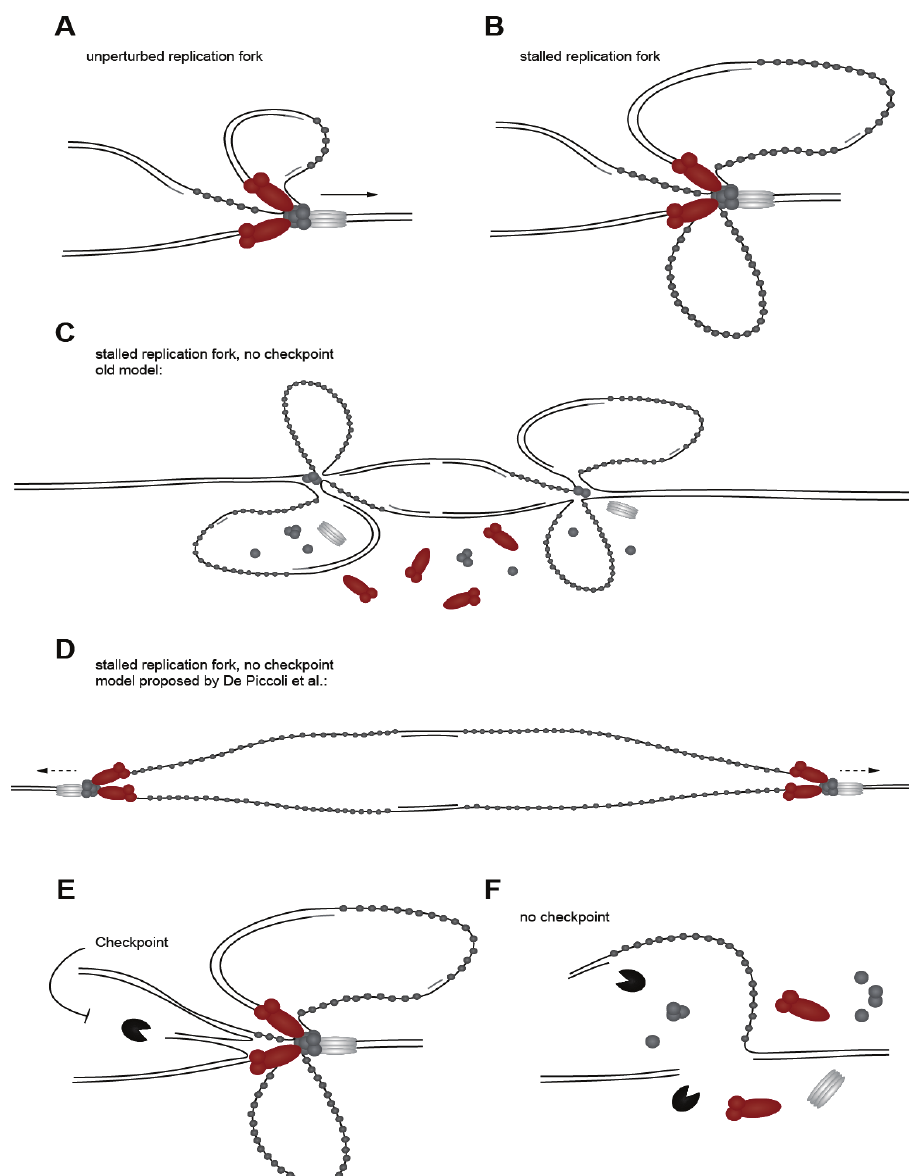
Figure 3. Replication fork stabilization. ( A ) A normal replication fork with leading and lagging strand polymerases, replicative helicase, and short ssDNA stretches coated